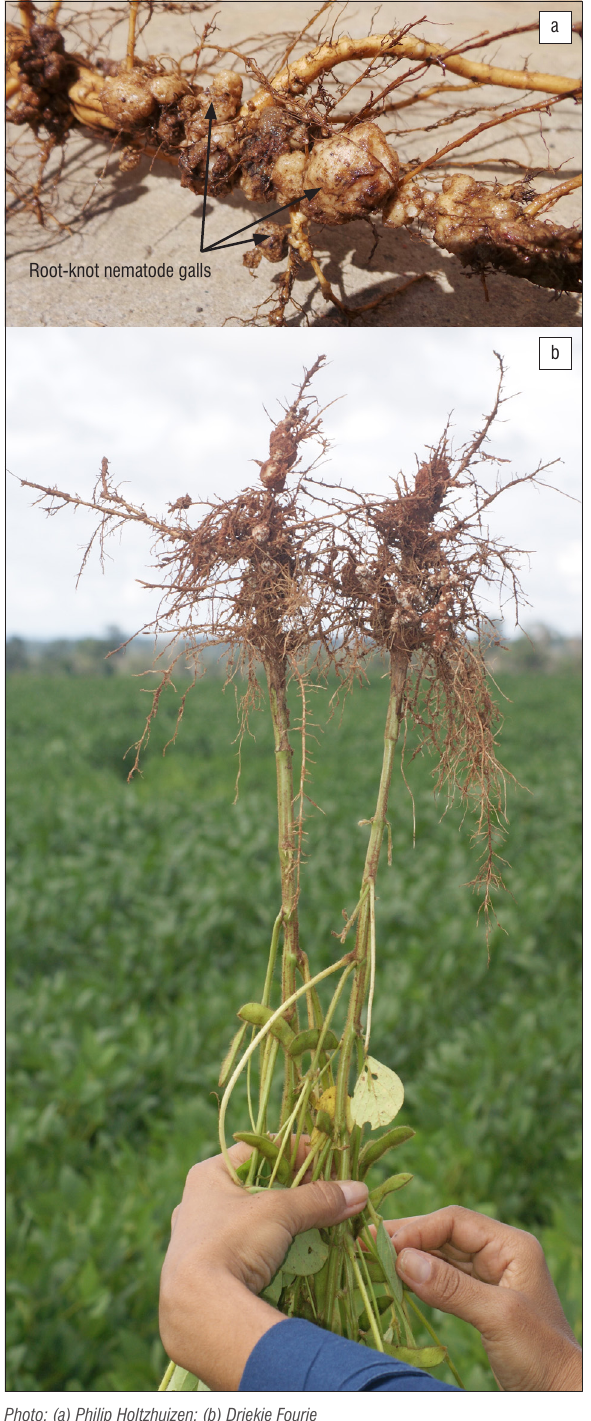
Figure 1: (a) Root-knot nematode galls, resulting from parasitism by Meloidogyne sp. females, on the roots of a soybean plant that was sampled during the 2013/2014 growing season in the Sasolburg area (Free State Province of South Africa). (b) Heavily galled root systems of two root-knot nematode infected soybean plants that grew in the Viljoenskroon area (Free State Province of South Africa) during the 2012/2013 growing